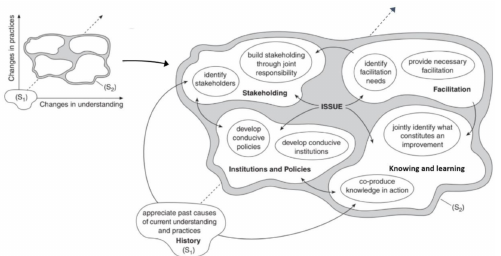
Figure 3. A framework for Social Learning for the Integrated Management and Sustainable Use of Water at Catchment Scale, adapted from Ison et al.